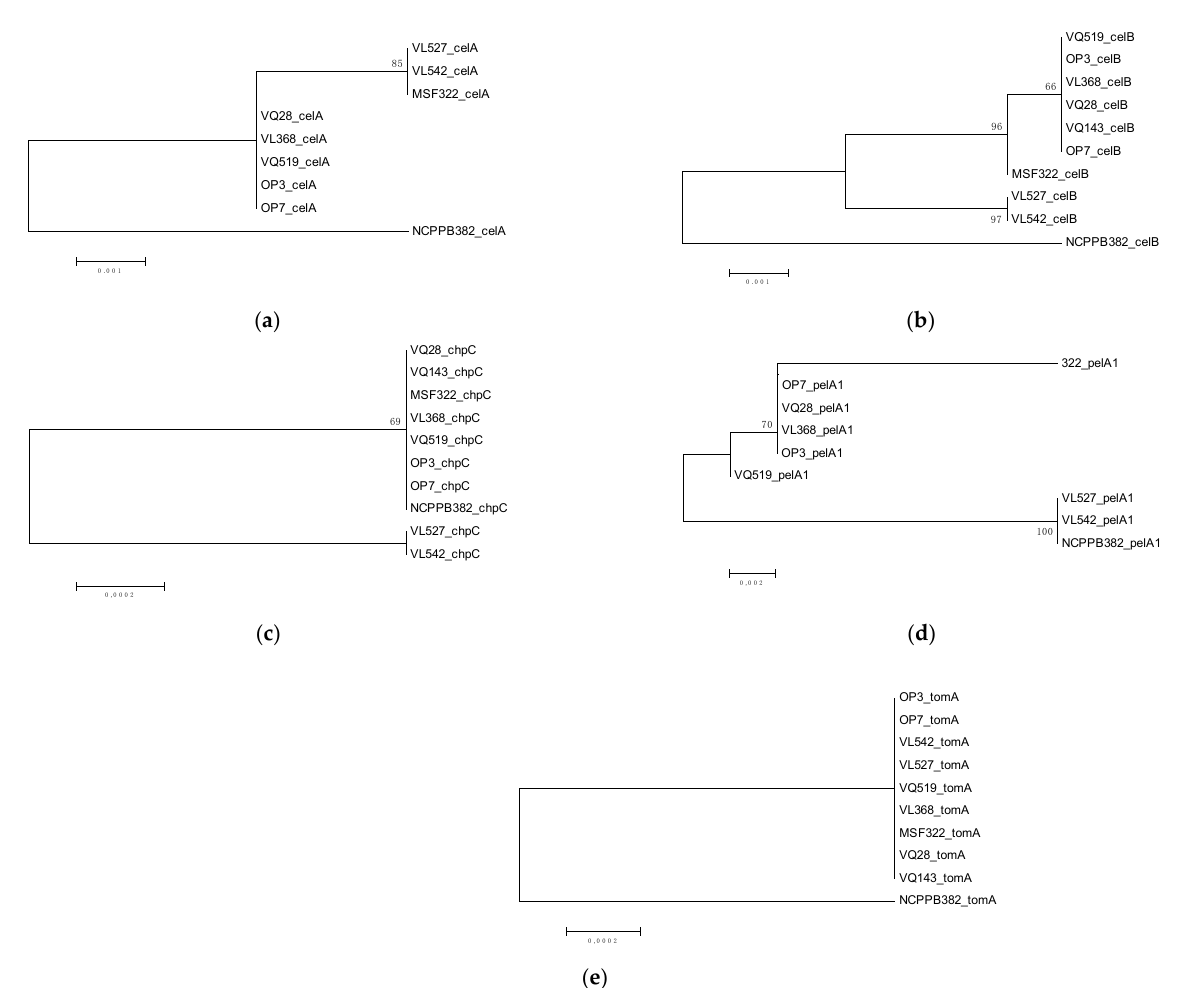
Figure 4. Cluster analysis of pathogenicity genes ( a ) celA , ( b ) celB , ( c ) chpC , ( d ) pelA1 , and ( e ) tomA for nine Chilean Clavibacter michiganensis subsp. michiganensis strains and reference strain NCPPB382.